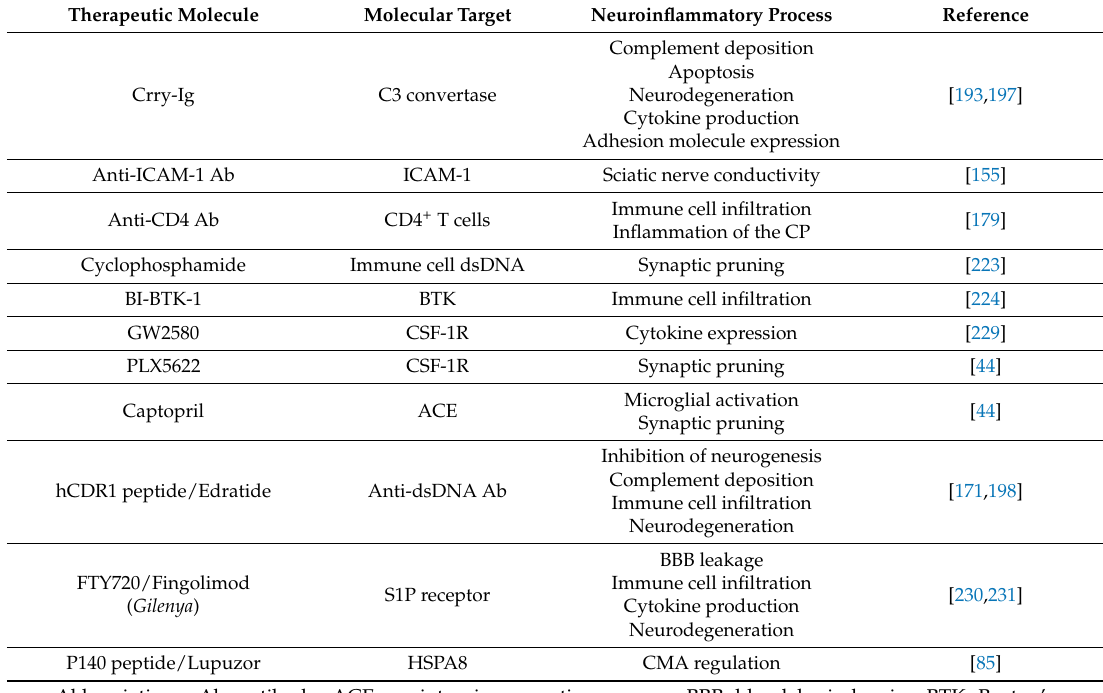
Table 3. Some therapeutic molecules acting in the brain and tested in lupus-prone murine